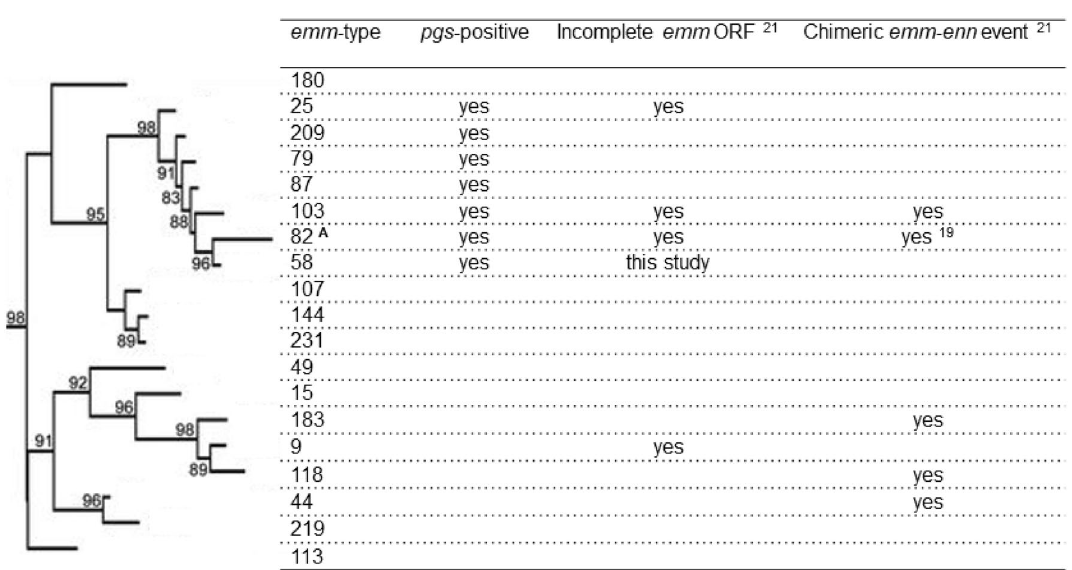
Figure 5. Phylogeny of group A Streptococcus E3 emm -cluster types. The tree has been labelled with the corresponding emm -type. The table summarises examples of recombination and mutation observed in the mga regulon of E3-type isolates. The tree is drawn to scale, with branch lengths in the same units (number of amino acid substitutions per site) as those of the evolutionary distances used for the phylogenetic tree. Approximate likelihood-ratio test values > 80% are indicated at the nodes. Adapted from Ref. 13 . Legend: ANGAS473, an emm82 isolate, inferred to have been the result of an emm-switch event has been previously described 18,19 , and was observed in this study to be